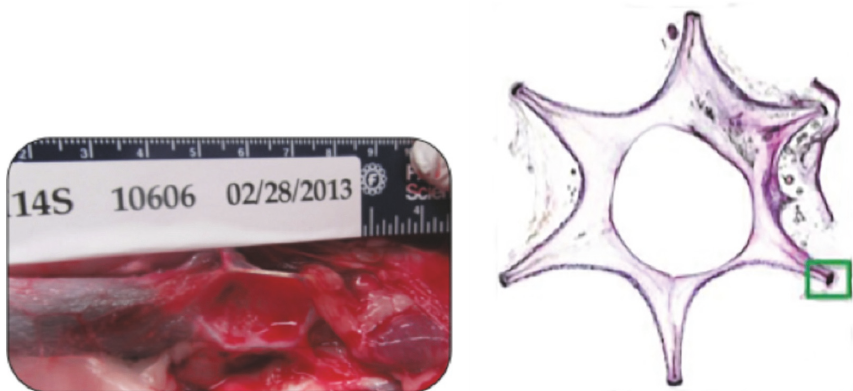
Figure 5: Imaging of the IVC segments with the control OptEase device (terminated at 183 days). Left: preexplant digital photograph of IVC sections with the implanted control OptEase Retrievable Vena Cava Filter. Right: a transverse section stained with toluidine blue/basic fuchsin, demonstrating incorporation of the device into the wall of the IVC.